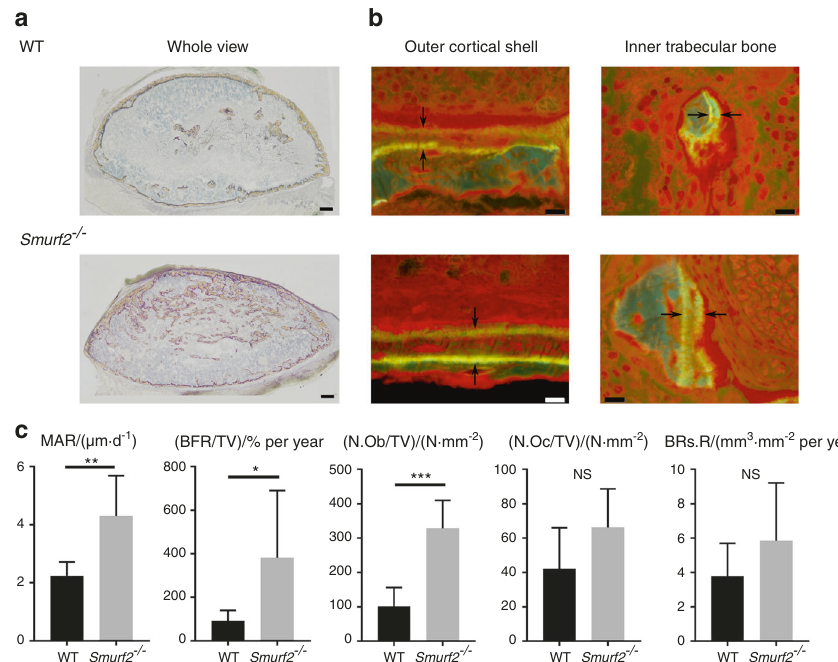
Fig. 3 Bone histomorphometry of rhBMP2-induced ectopic bone. a Villanueva bone staining of the whole rhBMP2-induced ectopic bone (scale bar = 200 μ m). b Fluorescence micrograph of the outer Ct. shell and inner Tb. bone in the rhBMP2-induced ectopic bone (scale bar = 10 μ m). The arrows indicate bone labeled with tetracycline or calcein. c Bone histomorphometric analysis of rhBMP2-induced ectopic bone. ( n = 6 WT mice, n = 7 Smurf2 − / − mice; * P < 0.05; ** P < 0.01; *** P < 0.001; NS, not signi fi cant by Student ’ s t